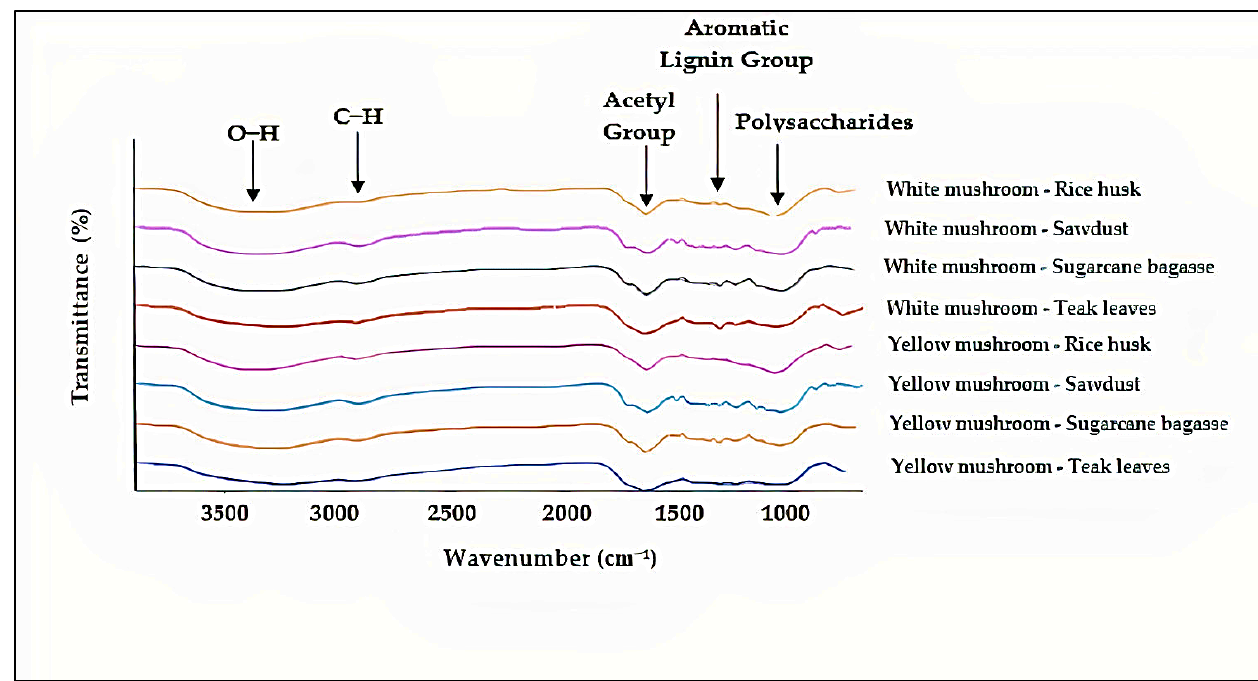
Figure 7. FTIR spectra of fungal foam from Pleurotus florida and Pleurotus citrinopileatus in different substrates.